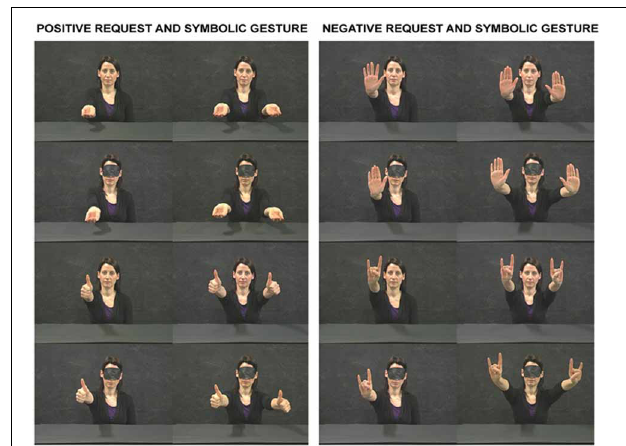
FIGURE 1 | Meaningful gestures produced by a conspecific and presented in Experiment 1. The conspecific could be blindfolded or not. The upper two rows show the final posture of request gestures and the lower two rows show the final posture of symbolic gestures. The two columns on the left show gestures with positive valence whereas the two columns on the right show gestures with negative